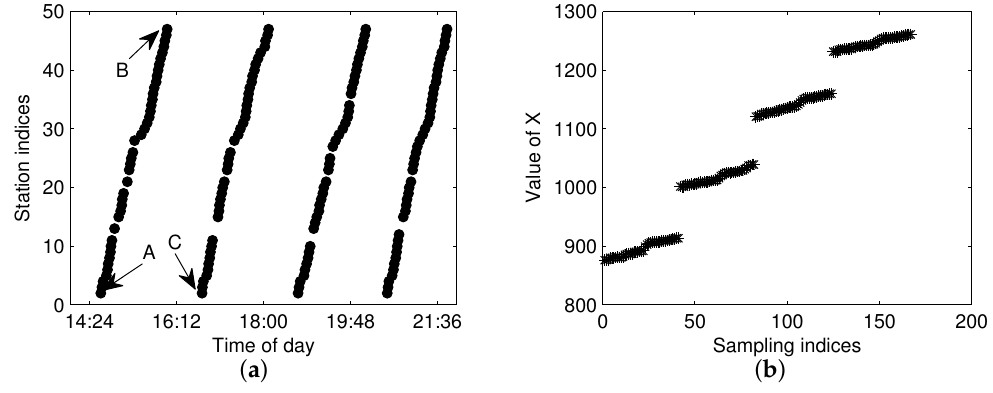
Figure 7. The constructed input feature of G ( m , l ) without abnormal data. ( a ) Arrival events; ( b ) constructed X